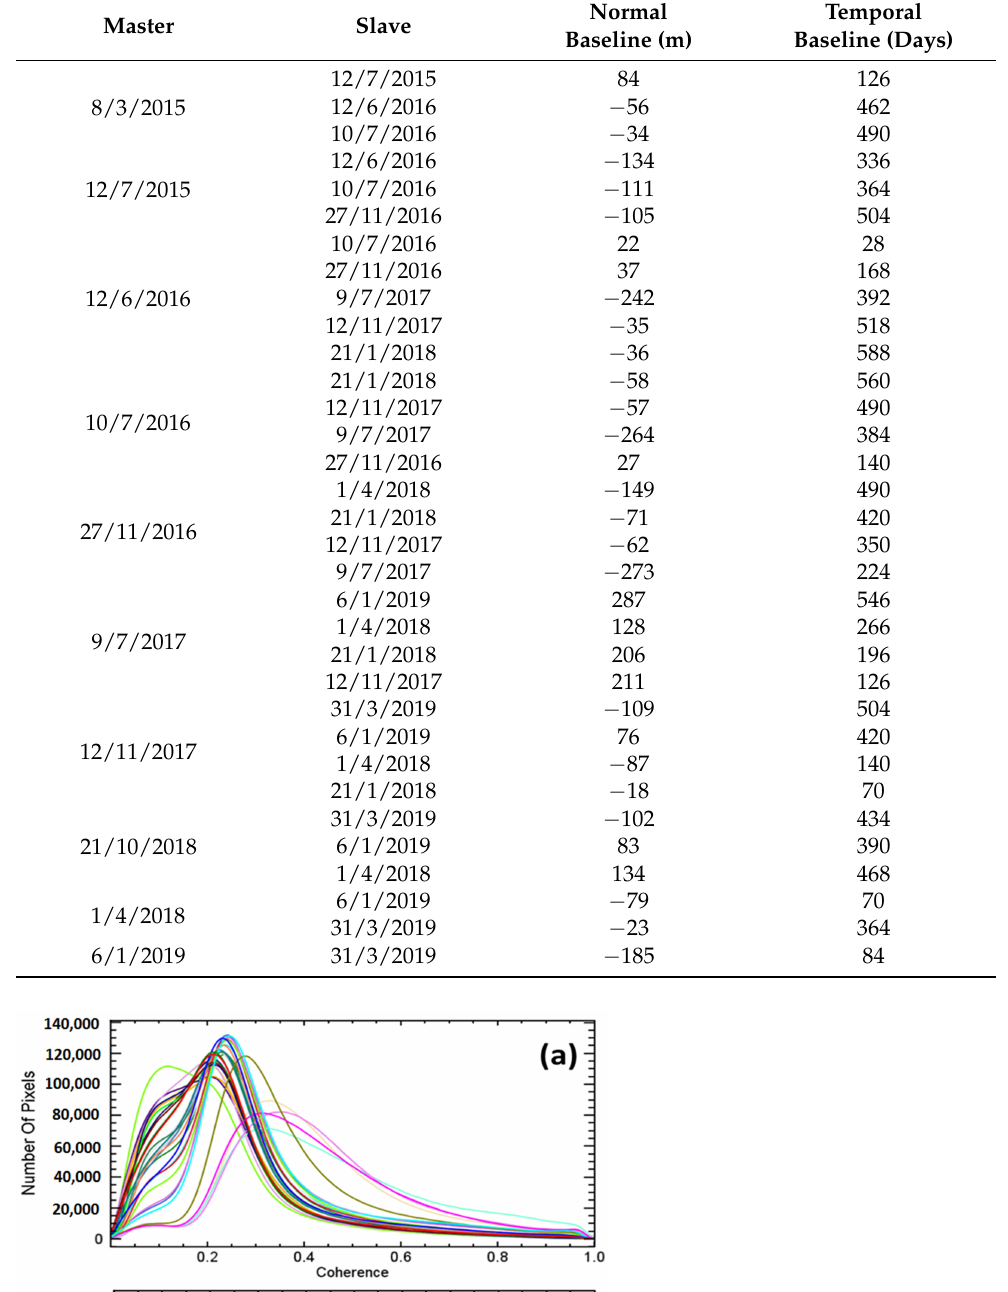
Table 3. ALOS/PALSAR-2 data pairs for SBAS processing.